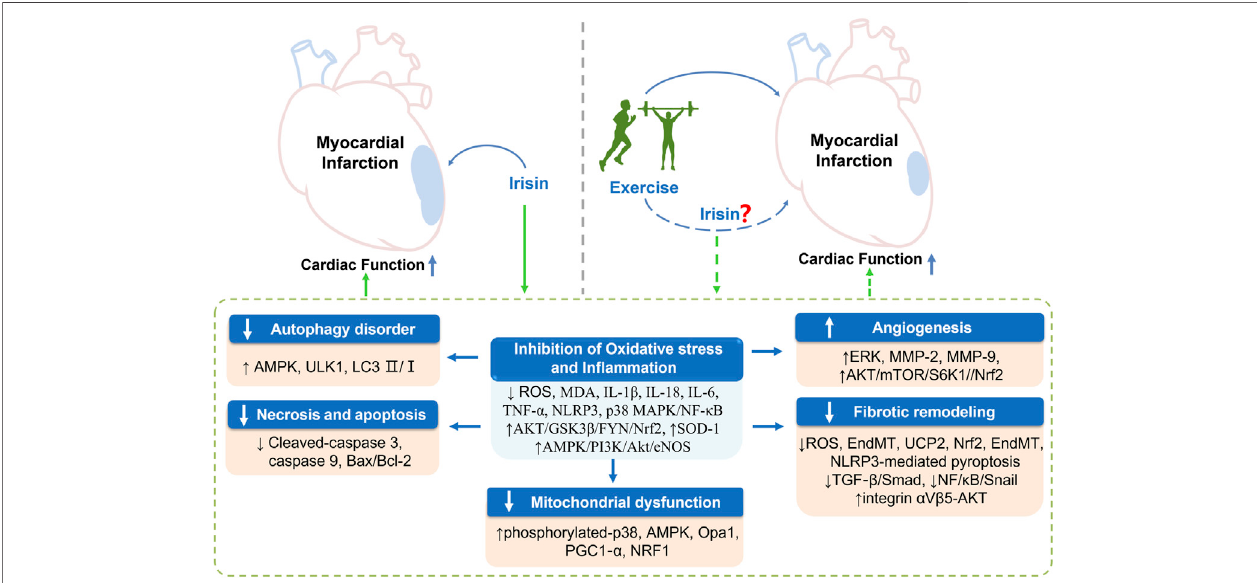
FIGURE 1 | Exercise exhibits cardioprotective effect against post-myocardial infarction by mediating irisin expression and the potential mechanisms. Exercise and exogenous intervention with irisin can improve impaired cardiac function after MI by inhibiting in fl ammation and oxidative stress, and further improving the abnormalities ofautophagy,apoptosis,andmitochondrialfunction,promotingangiogenesis,andinhibiting fi broticremodelingcausedbyinfarction.Meanwhile,exerciseisaneffective stimulus for upregulating irisin expression, however, whether exercise exerts the above bene fi cial effects through mediating irisin still needs to be veri fi ed by numerous studies. AMPK, adenosine 5 ′ -monophosphate-activated protein kinase; PI3k, phosphoinositide 3-kinase; AKT, protein kinase B; eNOS, endothelial nitric oxide synthase; Bax, bcl2-associated x; mTOR, mammalian target of rapamycin; IL-1 β , interleukin-1 β ; IL-18, interleukin-18; IL-6, interleukin-6; TNF- α , tumor necrosis factor- α ; ROS, reactive oxygen species; MAPK, mitogen-activated protein kinase; NF- κ B, nuclear factor kappa-B; NLRP3, nucleotide-binding oligomerization domain (Nod)-like receptor protein 3; MDA, malondialdehyde; SOD-1, superoxide Dismutase-1; GSK3 β , glycogen synthase kinase-3 β ; Nrf2, NF-E2-related factor; OPA1, optic atrophy 1; ULK1, uncoordinated 51-like kinase 1; NRF1, nuclear respiratory factor; PGC1- α , peroxisome proliferator-activated receptor- γ coactivator-1 alpha; ERK, extracellular regulated protein kinases; MMP-2, matrix metallo-proteinase-2; MMP-9, matrix metallo-proteinase-9; EndMT, endothelial-to-mesenchymal transition.